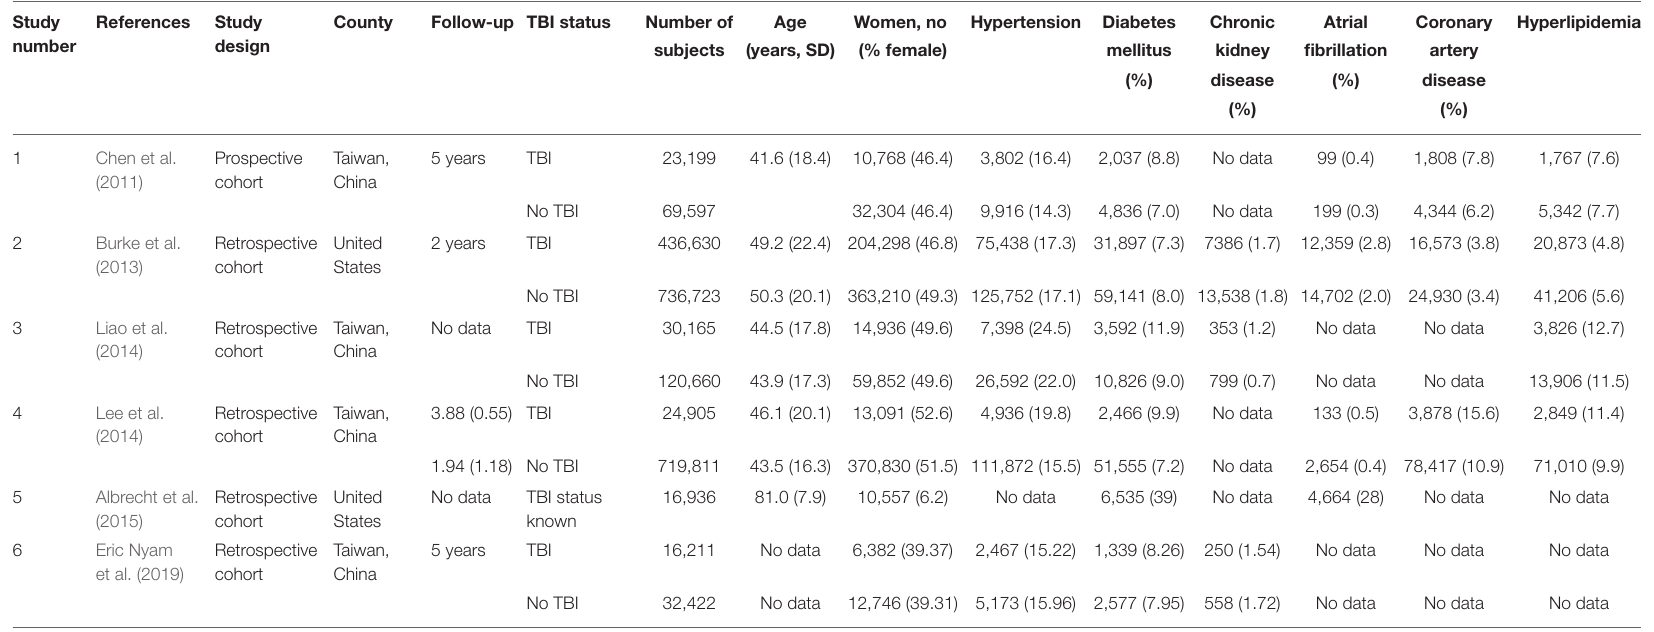
TBI, traumatic brain injury; SD, standard